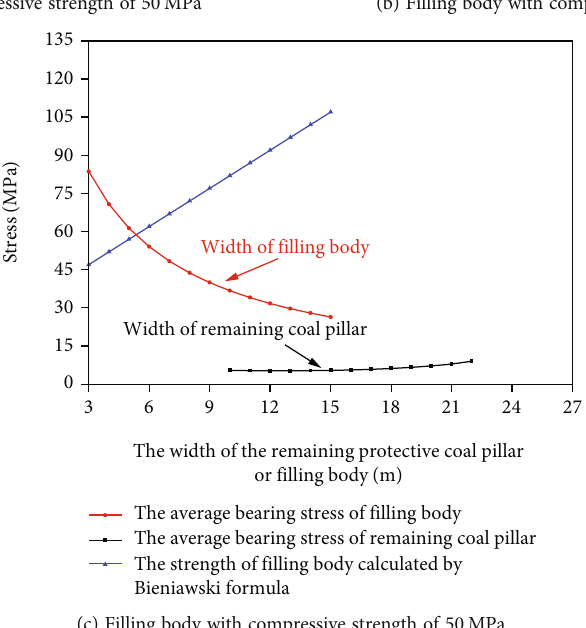
Figure 5: Average stress shared by fi lling body and remaining coal